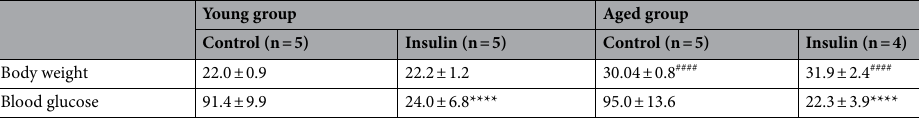
Table 1. Body weight (g) and blood glucose concentration (mg/dl) in organ 18 F-FDG accumulation study. Data in parentheses are mean ± SD. Control, control group; Insulin, insulin-loaded group. **** P < 0.0001 vs control value. # ### P < 0.0001 vs young groups in control and insulin-loaded groups.